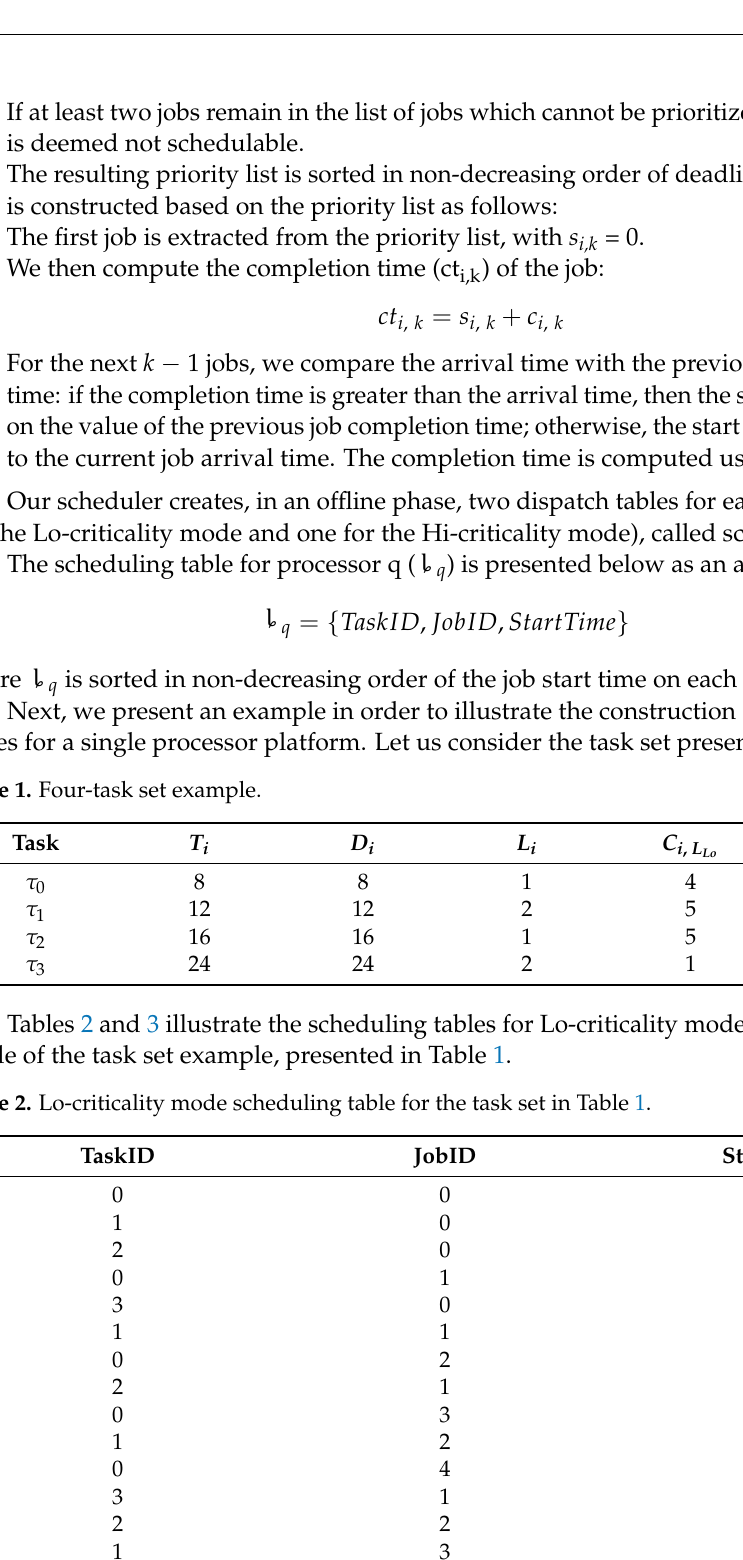
Table 3. Hi-criticality mode scheduling table for the task set in Table 1.